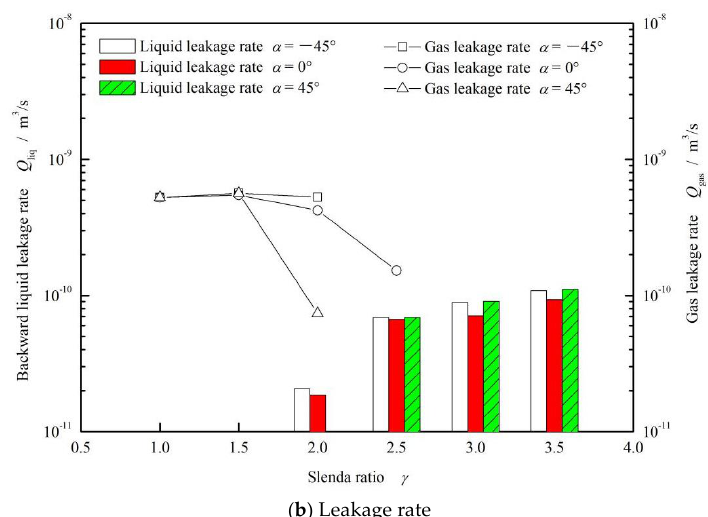
Figure 8. Effect of slenderness ratio of elliptical grooves on the opening force ( a ) and leakage rate ( b ). ( ω = 10,000 rpm, p o = 0.3 MPa, h 0 = 2 μm and N = 36).